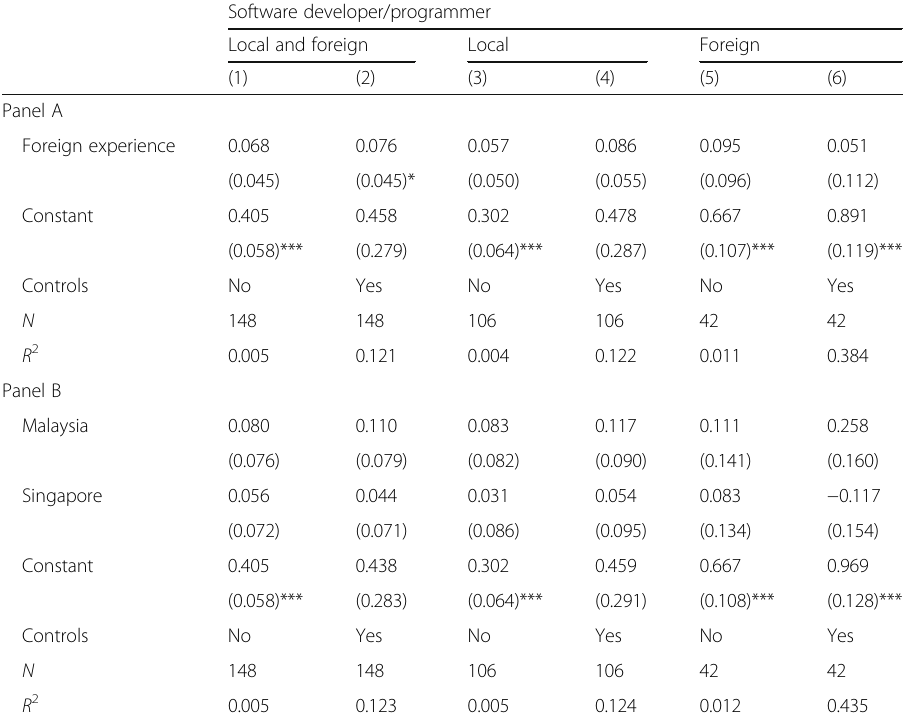
Table 10 Dependent variable: if a resume receives a callback for an interview (software developer/ programmer)